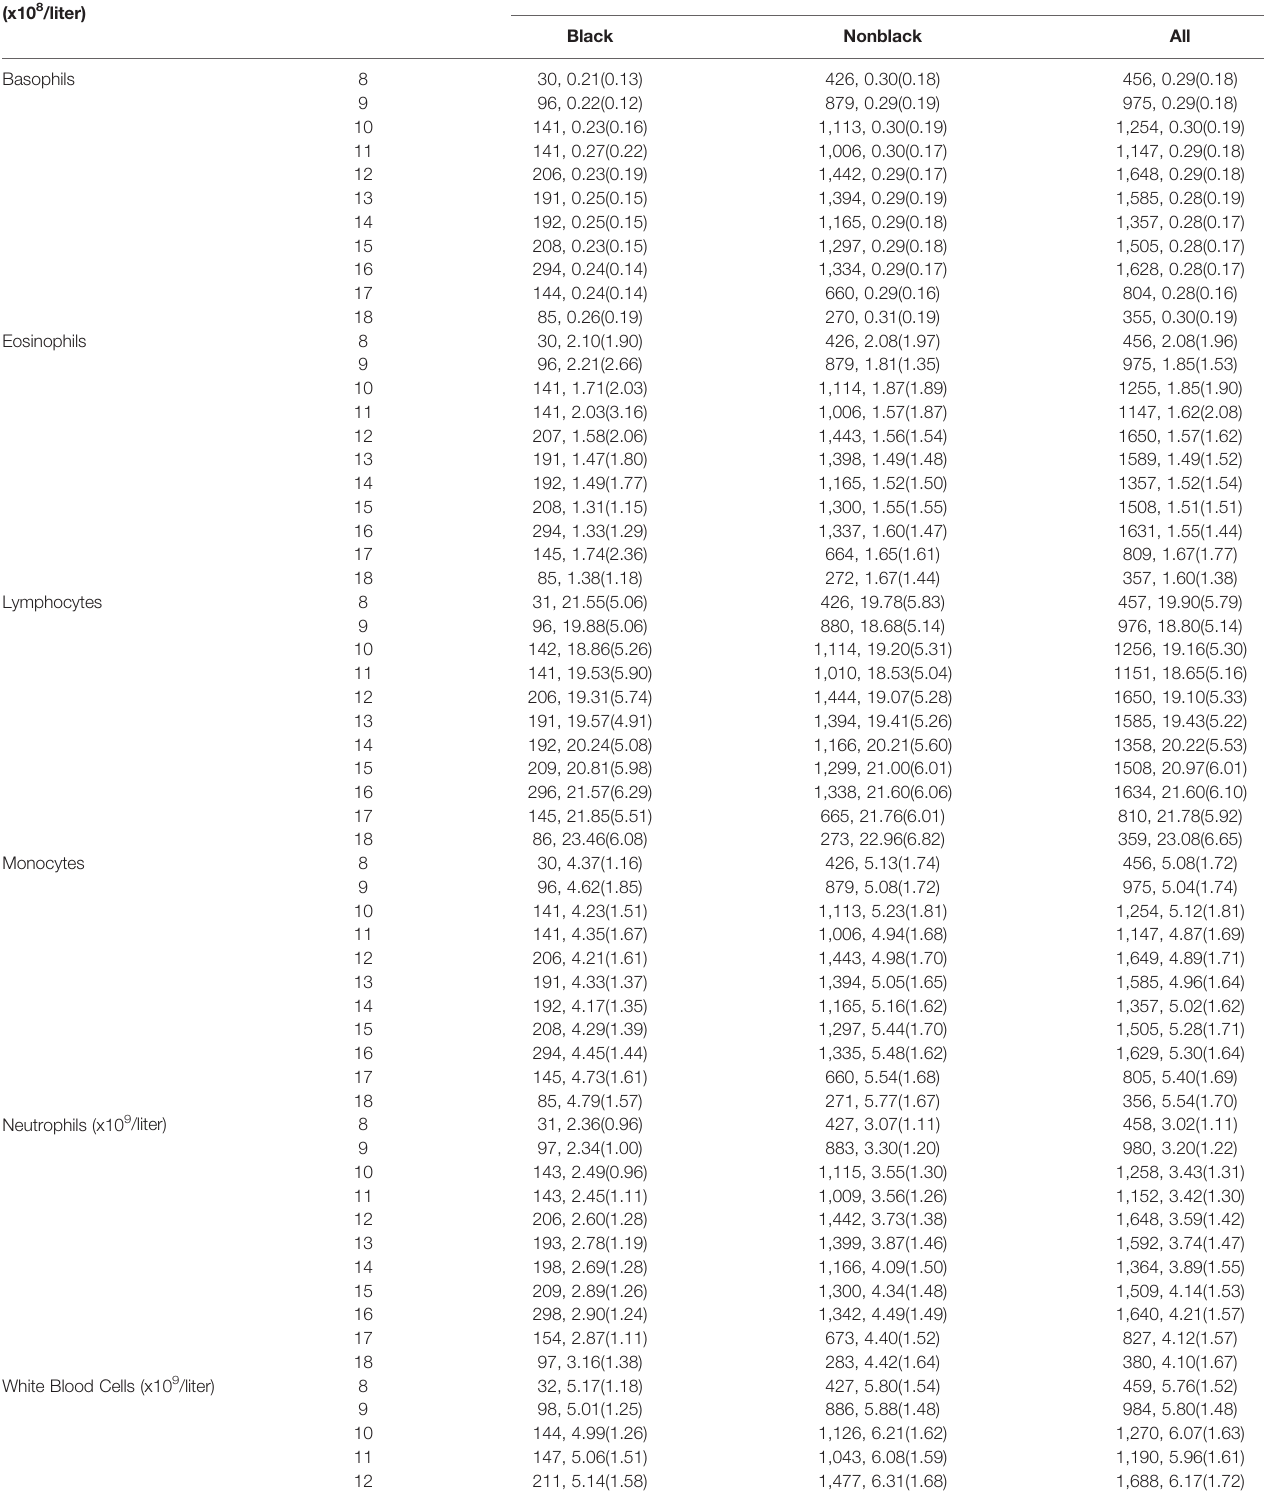
TABLE 3 | Summary statistics of haematological parameters [Basophils, Eosinophils, Neutrophils, Lymphocytes, Monocytes, and white blood cell (WBC)] for black and nonblack populations by time of day. Parameter (x10 8 /liter)